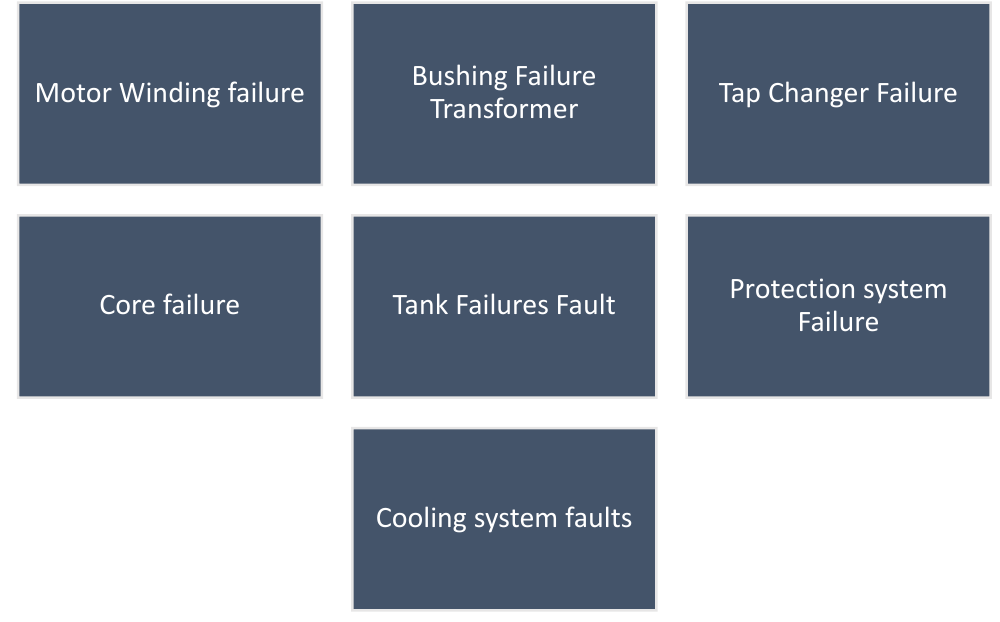
Figure 4. Power system failures.